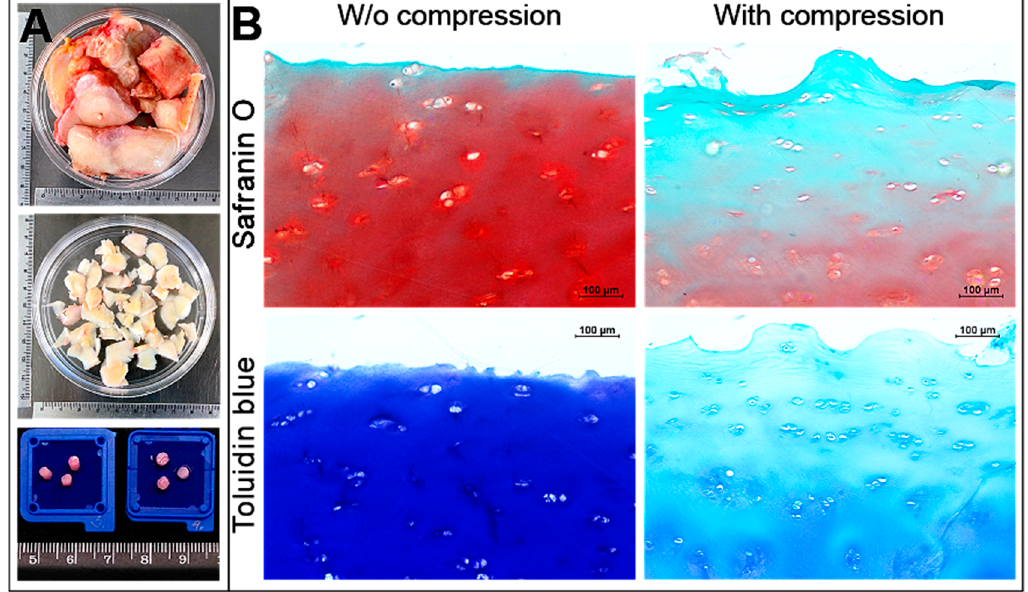
Figure 4. The effect of mechanical load on human OA cartilage explants. ( A ) The macroscopic view of received parts of human joint, chopped cartilage and prepared the explant circles for further experiments. ( B ) Histochemical staining of proteoglycans with safranin O (red/orange) and with toluidine blue (blue) with/without mechanical compression (30 kPa, 1 Hz, 1 h/day for 7 days). The human OA cartilage was removed from the joint bone, cut into round circles as